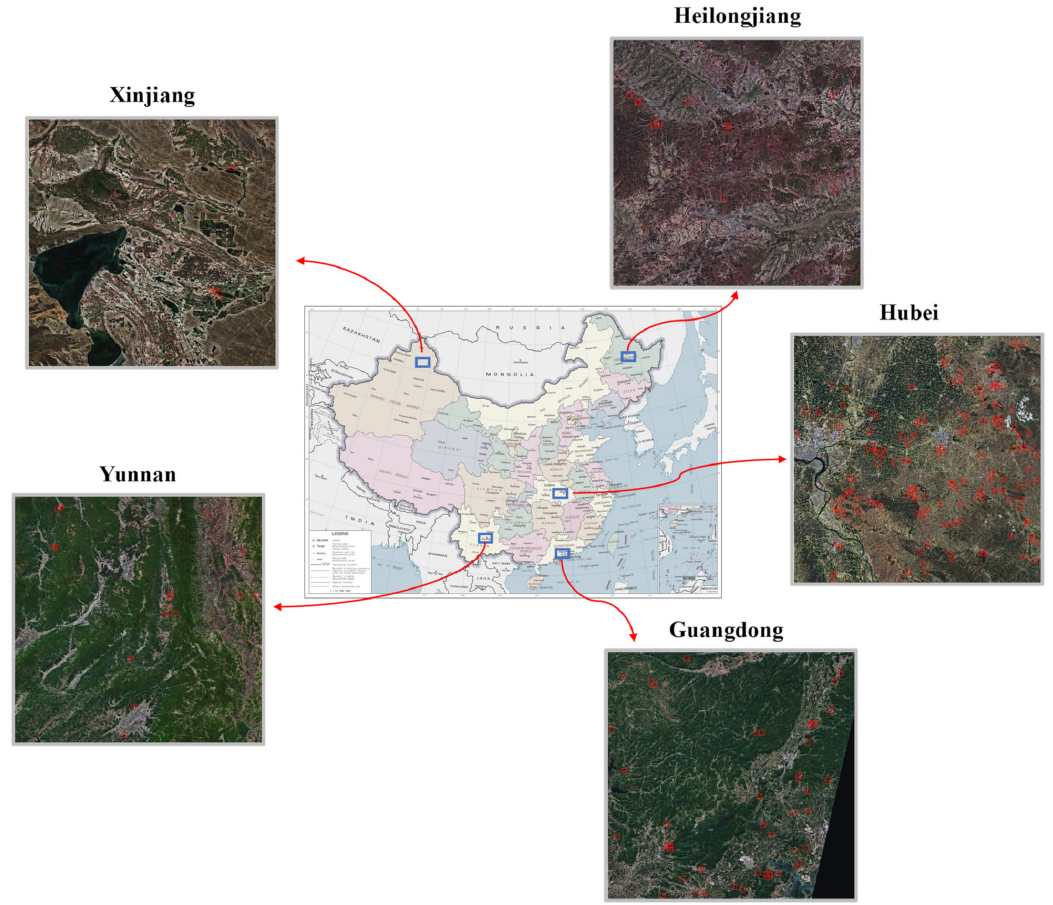
Figure 13. Visualization of the detection results with single TIF image in various provinces (the red bounding boxes are zoomed to 100 × 100 pixels for better